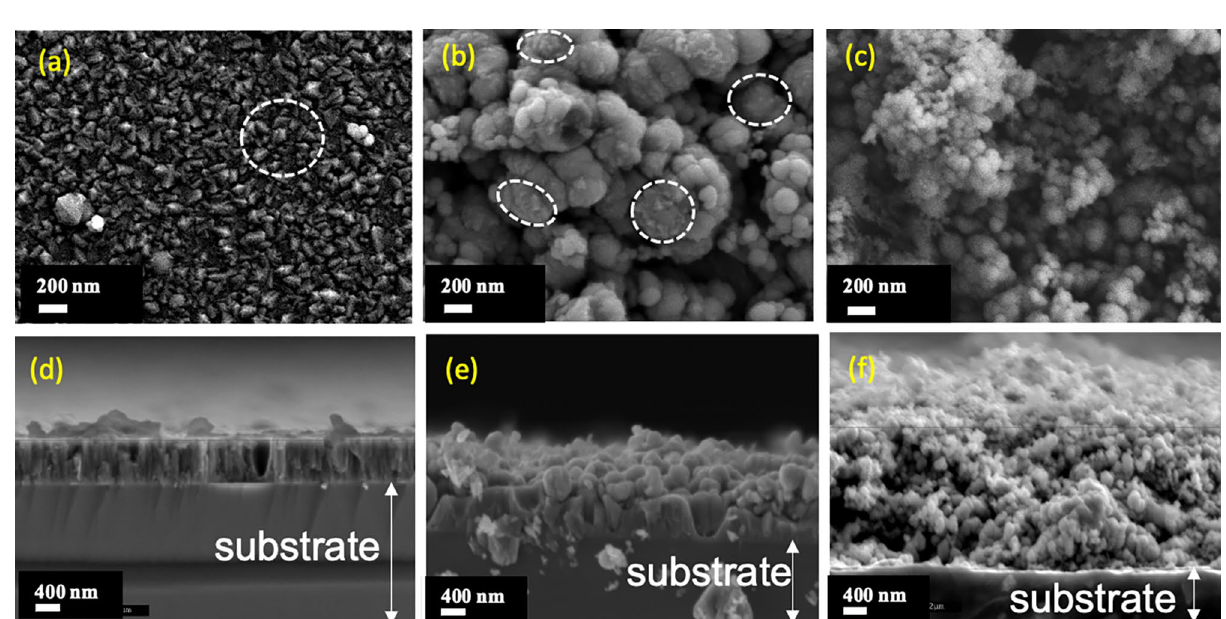
Figure 4. Topographies of TiO 2 /SiO 2 -np films synthesized from different concentrations of SiO 2 -np suspension: ( a ) 0.0 g l −1 SiO 2 -np suspension; ( b ) 0.1 g l −1 SiO 2 -np suspension; ( c ) 1.0 g l −1 SiO 2 -np suspension, and cross-section images: ( d ) 0.0 g l −1 SiO 2 -np suspension; ( e ) 0.1 g l −1 SiO 2 -np suspension; ( f ) 1.0 g l −1 SiO 2 -np